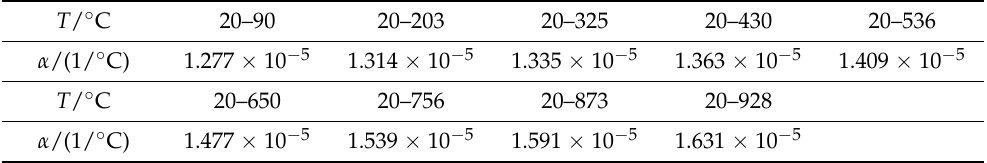
Table A3. Thermal expansion coefficient ( α ) of stationary solid material.